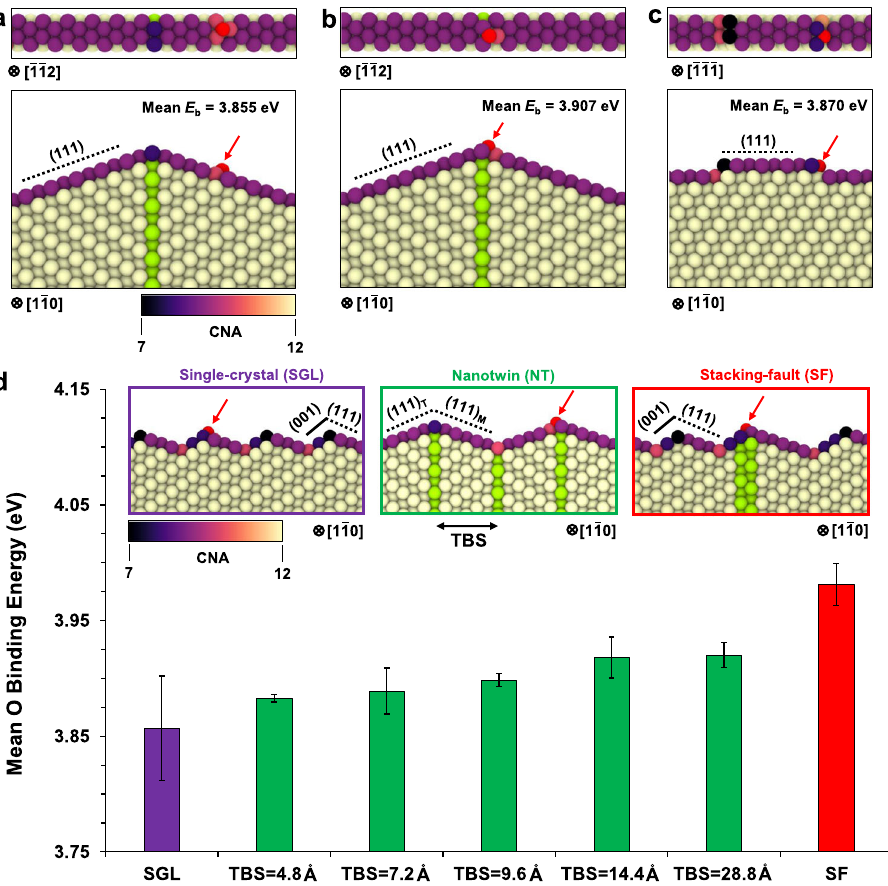
Fig. 2 Density functional theory based calculations of the mean Ag – O binding energy at different surface sites of single crystal (SGL), nanotwinned (NT) and stacking fault (SF) contained Ag. a , b Mean oxygen binding energy ( E b ) at the atomically smooth (111) facets and the twinned tip, respectively. The oxygen atom is shown in red colour. Atoms at the planar faults are highlighted in green and other atoms in Ag are coloured using the coordination number analysis (CNA), as de fi ned by the colour scale bar (black for lowest CN = 7 and yellow for highest CN = 12). c Mean E b for a (111) kink step in SGL Ag. d Mean E b at different surface sites of SGL, NT and SF contained Ag nanocrystals, where the twin-boundary spacing (TBS) varies from 4.8 Å to 28.8 Å. The highest mean E b is predicted to occur near isolated TBs (TBS = 14.4 Å and 28.8 Å) and near the SF. The different surface con fi gurations are shown in the insets, where the (001) and (111) surface facets are delineated with solid and dotted lines, respectively. Error bars represent the standard deviations from statistical analyses, where the two highest energies ( n = 2) are chosen for each nanocrystal con fi